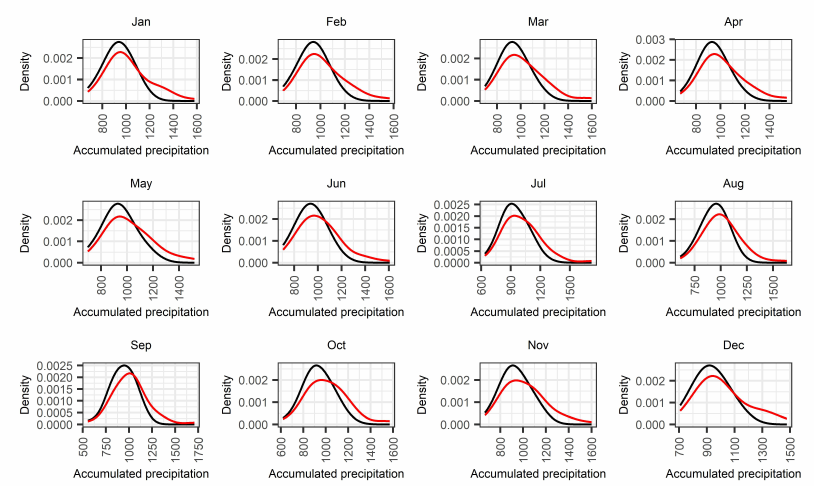
Figure 8. Comparison of the density estimates of the accumulated rainfall between Y ( 12 )( k ) (black) and Y ( 12 )( k , l , m ) (red).